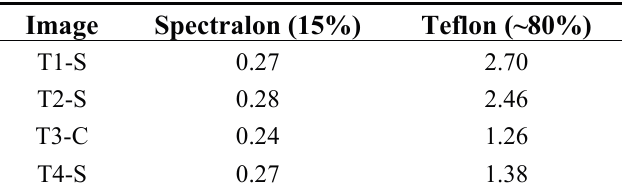
Table 3. Average values of mean/variance (1948–2404 nm) from a bright (teflon) and dark (spectralon) target, indicative of the relative amounts of noise in each image. Note smaller values represent greater amounts of